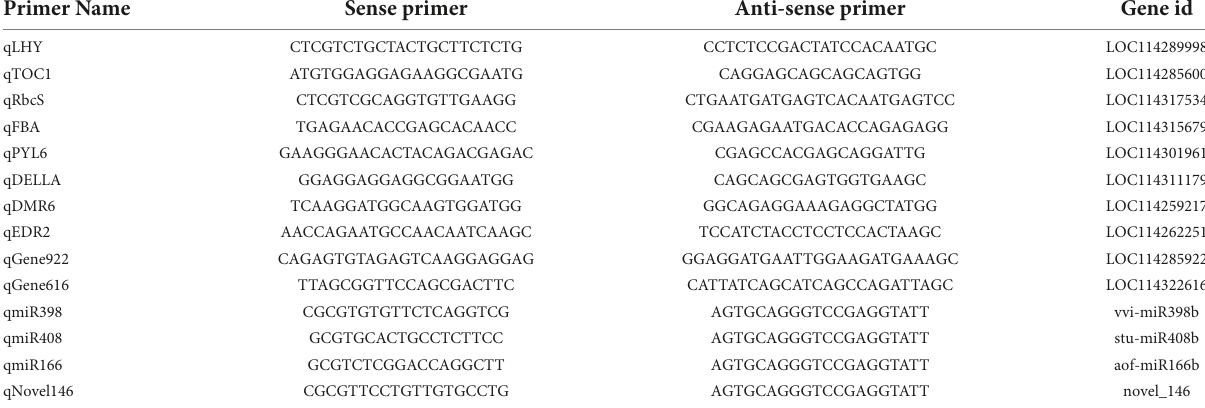
TABLE 1 Information on primers used in the quantitative real-time PCR (qRT-PCR)